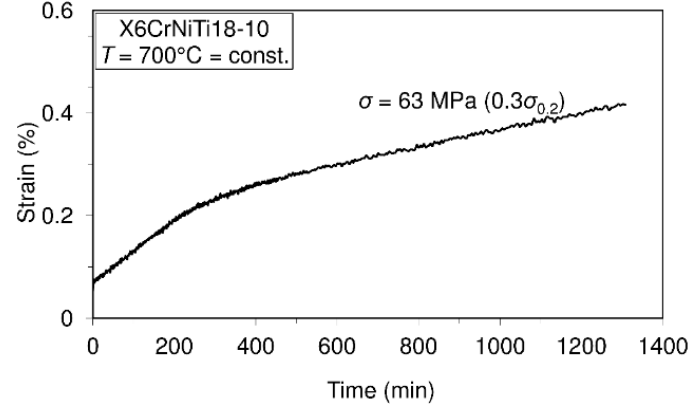
Figure 8. Creep behavior of steel X6CrNiTi18-10 at a temperature of 700 °C.